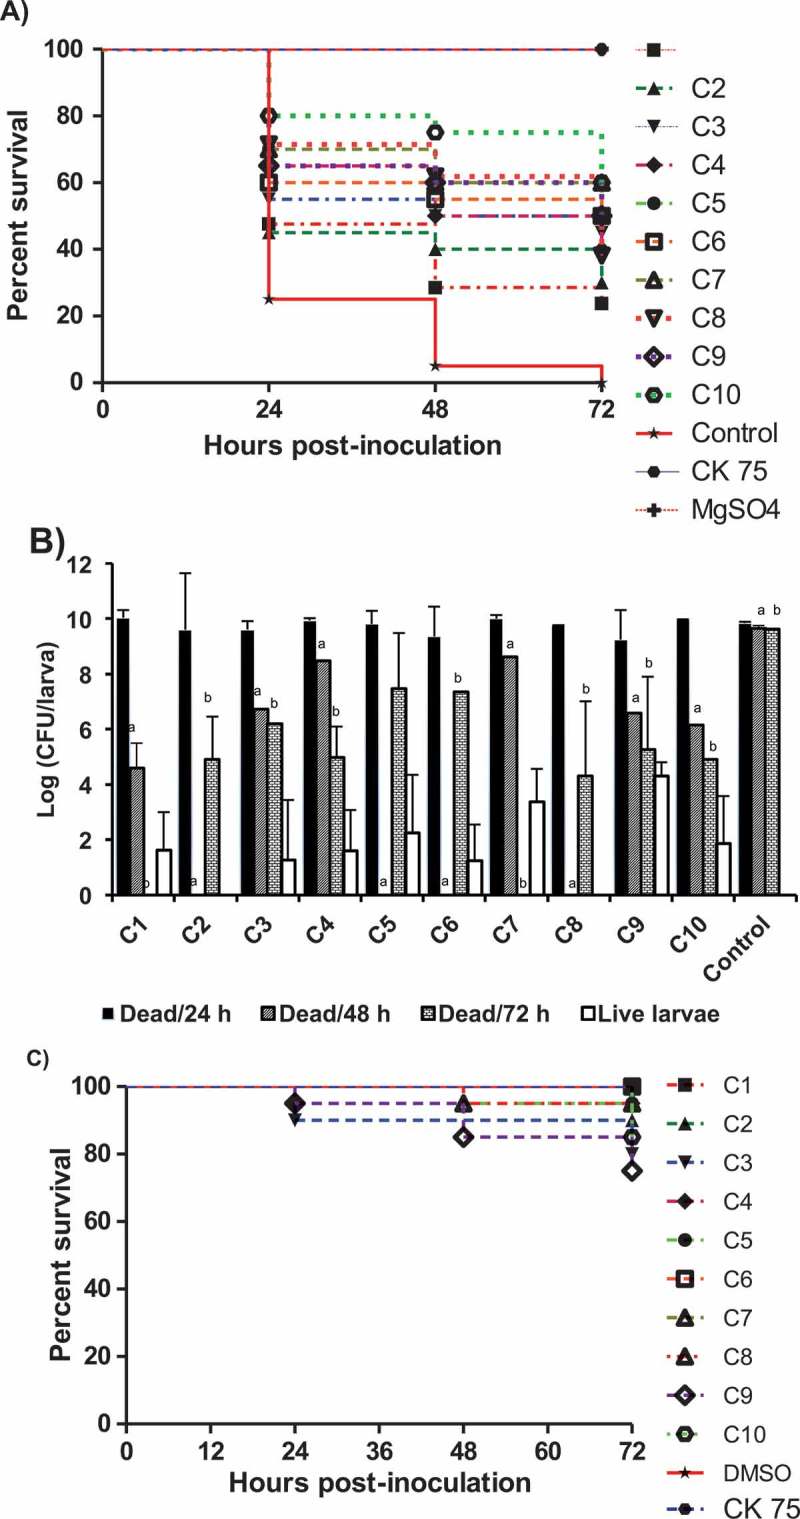
Effect of the AI-2 inhibitors on G. mellonella larvae infected with APEC O78; A) survival rate of the treated larvae, B) bacterial load in dead larvae at different time points (24, 48, 72 h) and in live larvae at 72 h, and C) toxic effect of each compound on G. mellonella larvae. The larvae were treated with the AI-2 inhibitors (12.5 µg/larva) and inoculated with APEC O78 (8.5 µL ~ 4.25 × 104 CFU), survival monitored for 72 h. The results of two independent experiments were averaged. Significant difference between AI-2 inhibitors treated compared to DMSO treated control at 48 ha and 72 hb (P < 0.05).